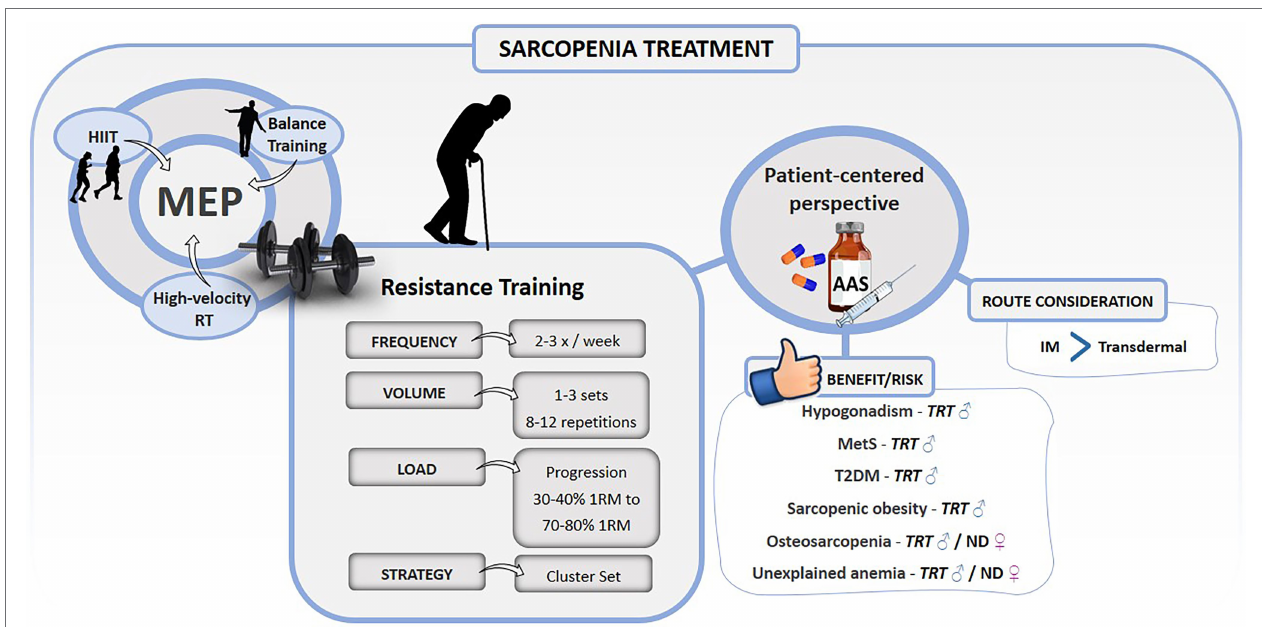
FIGURE 1 | Summary of exercise training and anabolic androgenic steroids recommendations for the treatment of sarcopenia. 1RM , 1 repetition maximum; AAS , anabolic androgenic steroids; HIIT , high-intensity interval training; IM , intramuscular; MetS , metabolic syndrome; ND , nandrolone decanoate; RT , resistance training; T2DM , type 2 diabetes mellitus; TRT , testosterone replacement therapy; ♂ : men; and ♀ :